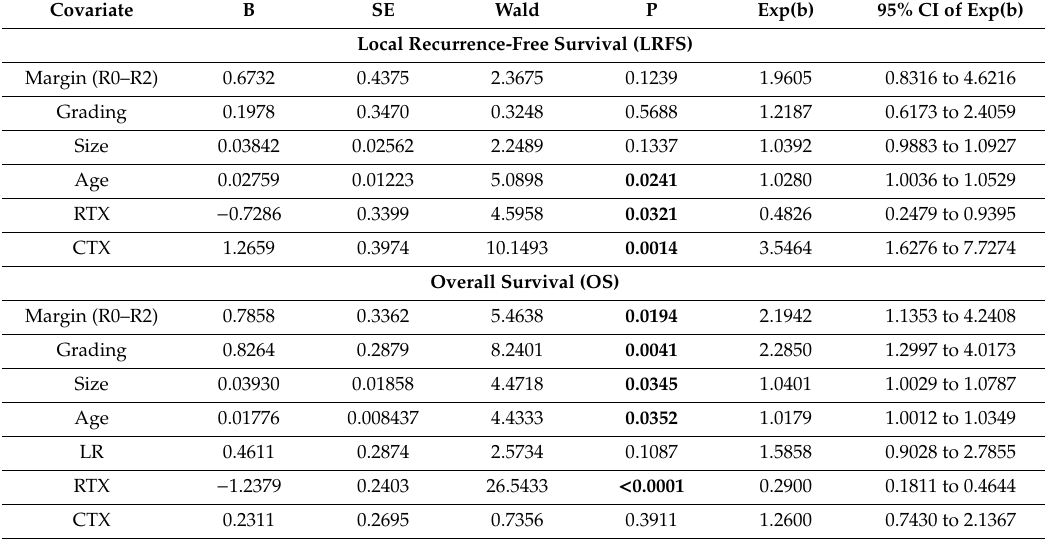
Table 2. Factors influencing local recurrence-free survival (LRFS) and overall survival (OS). Multivariate Cox proportional-hazards regression in 305 patients.